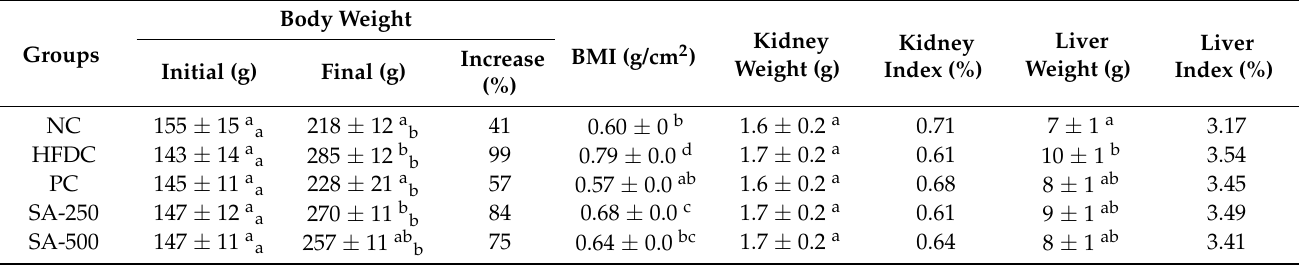
Table 3. Effect of herbal tea and orlistat on the body, kidney and liver weights, body mass, kidney and liver index of different groups of obesity rat